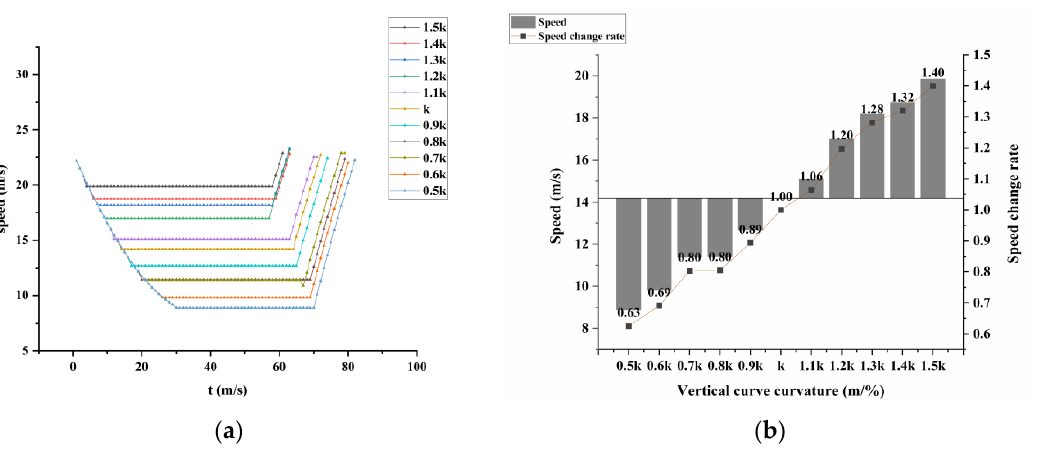
Figure 2. Speed change diagram of heavy-duty diesel vehicle: ( a ) Instantaneous speed versus time graph; ( b ) the speed change amplitude diagram in crest vertical curve